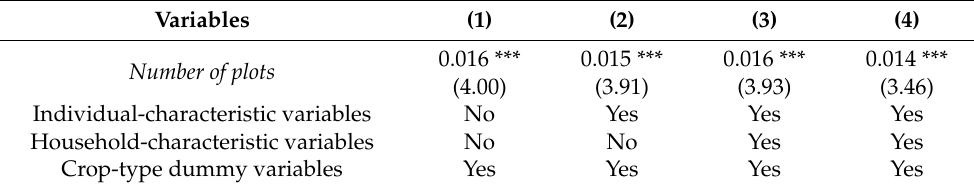
Table 5. Effects of the degree of cultivated land fragmentation on fertilizer-application amount per